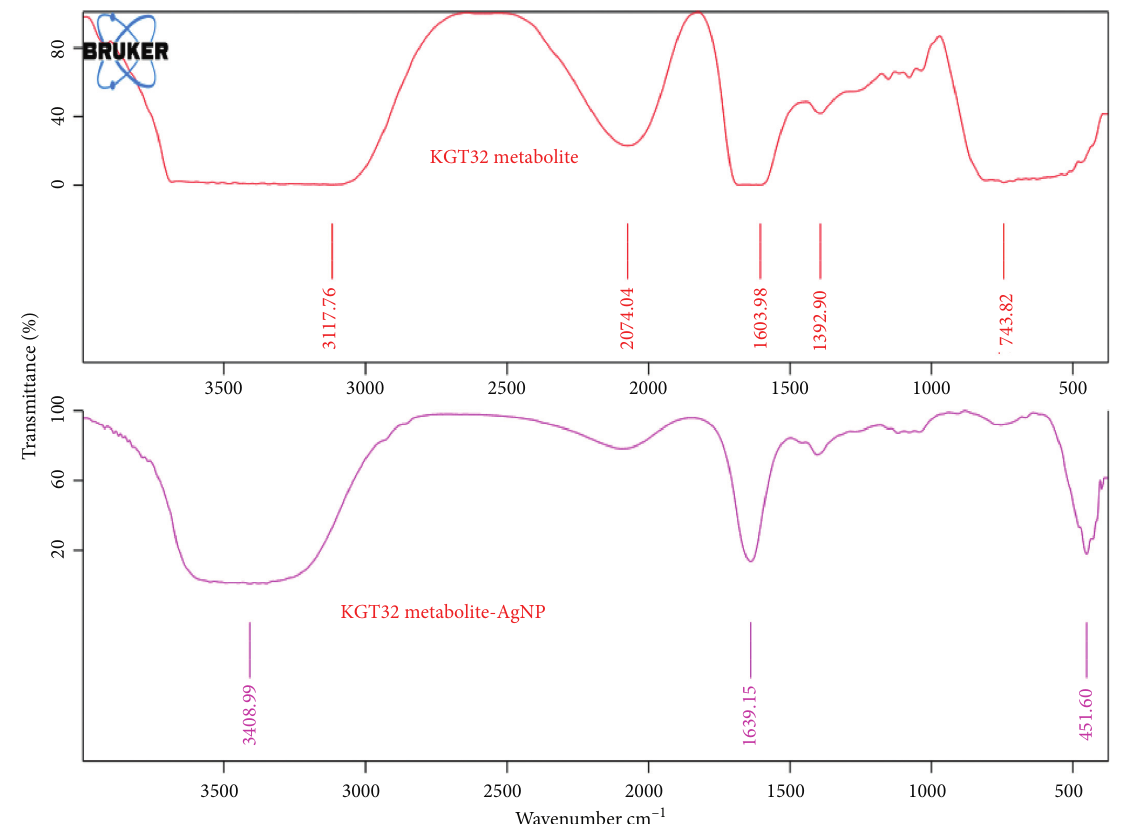
Figure 5: Comparison of the FTIR spectra of KGT32 metabolite and KGT32-AgNPs.